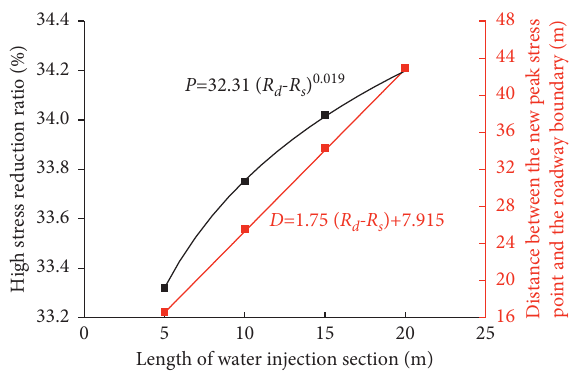
Figure 9: Hydraulic fracturing effect under different water injection section lengths.